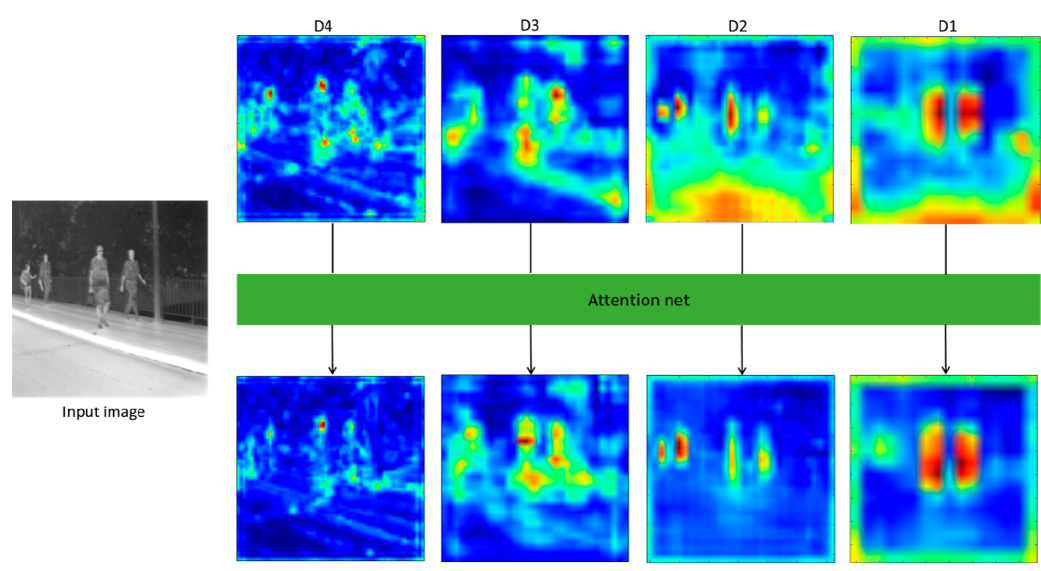
Figure 4. Visualization of feature maps from decoder module (top) and visualization of feature maps from the attention module (bottom).